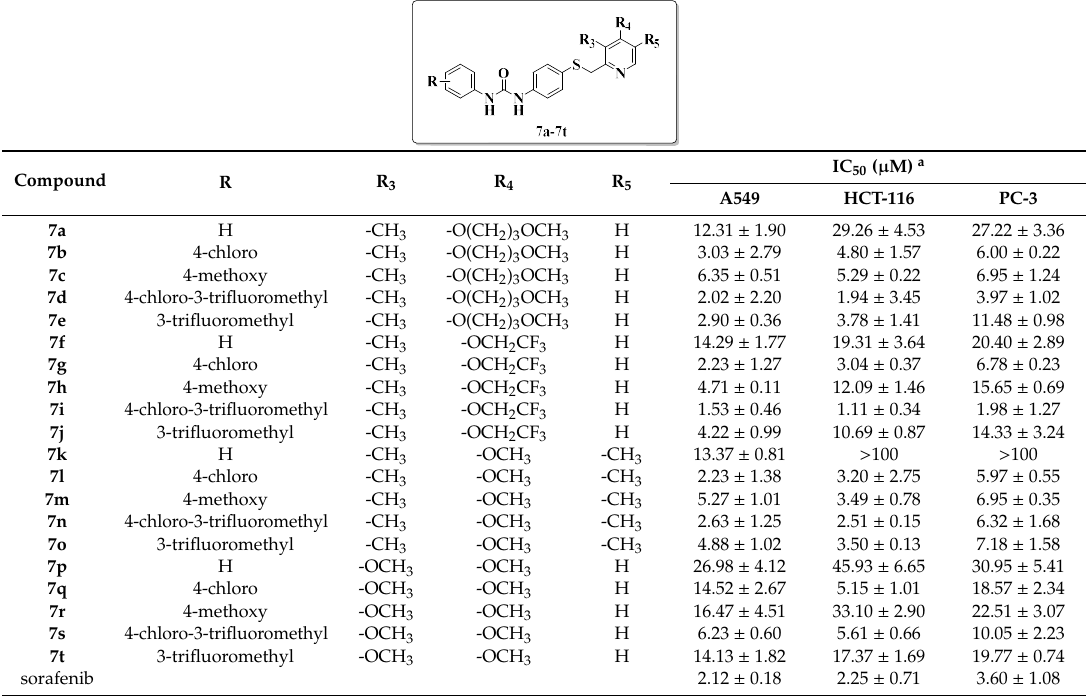
Figure 5. SARs summary for the target compounds. Table 1. The chemical structures and inhibitory activities of the target compounds.